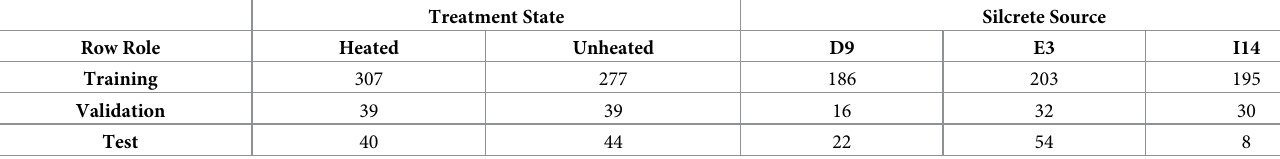
Table 3. k-NN model A observation roles for training, validation, and testing.